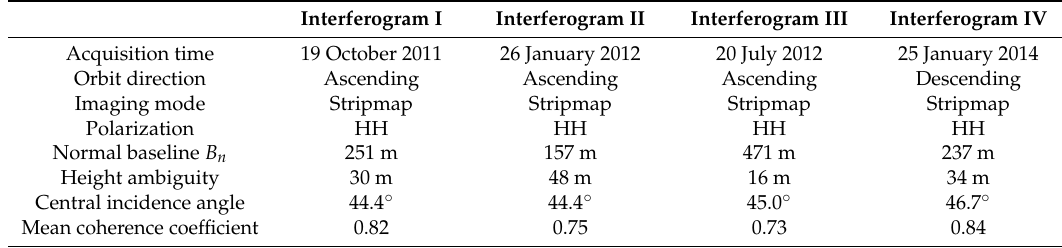
Table 1. Parameters for bistatic TanDEM-X interferometric pairs.